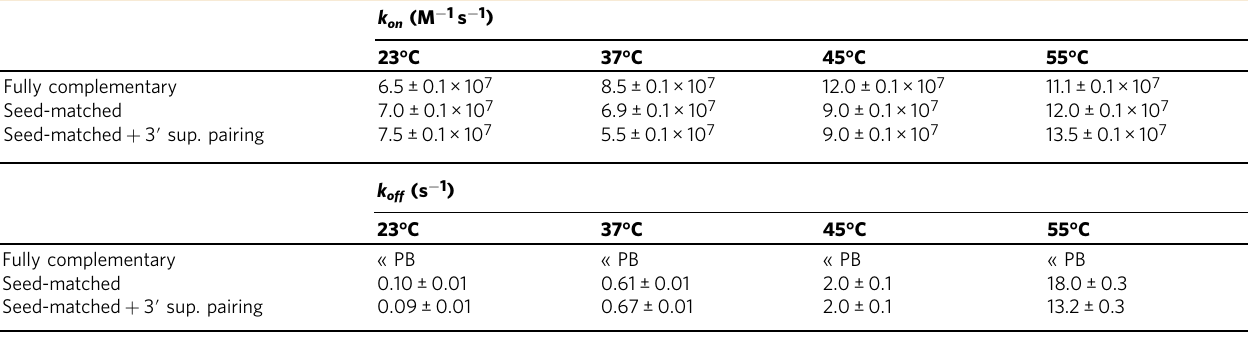
Table 1 Properties of DNA-guided TtAgo binding to DNA targets with different extents of complementarity to the guide-strand at various